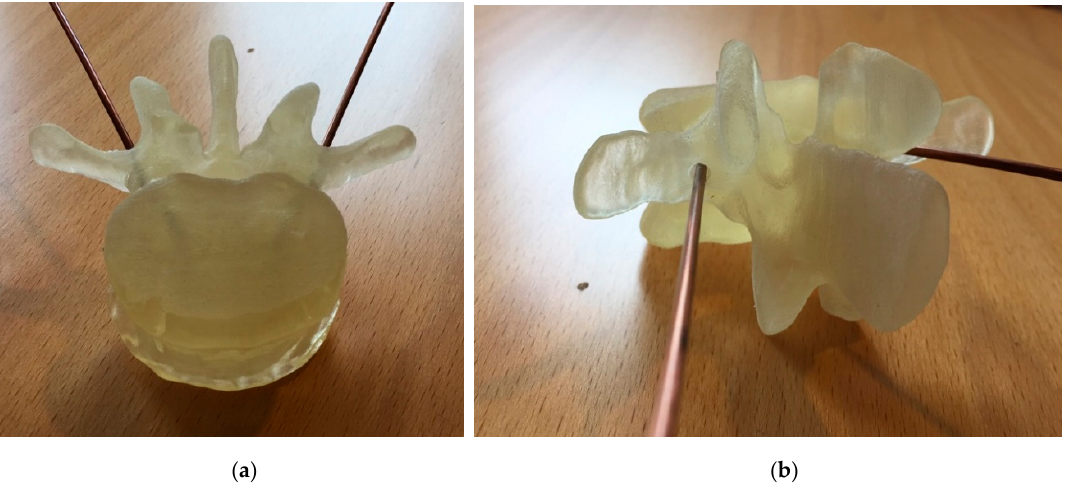
Figure 8. Photographs of a 3D printed human vertebrae (lower lumbar) with two coaxial probes inserted into holes formed through the pedicle arms into the main portion: ( a ) top down view with the probes partially visible with the plastic and ( b ) a side view showing the hole that the probe is inserted into.